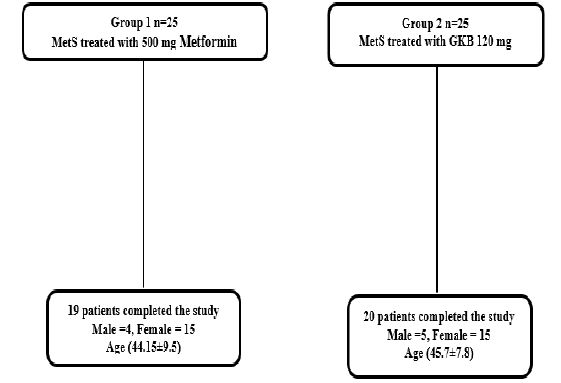
Figure 1. Flowchart shows the screening, recruitment and randomization of